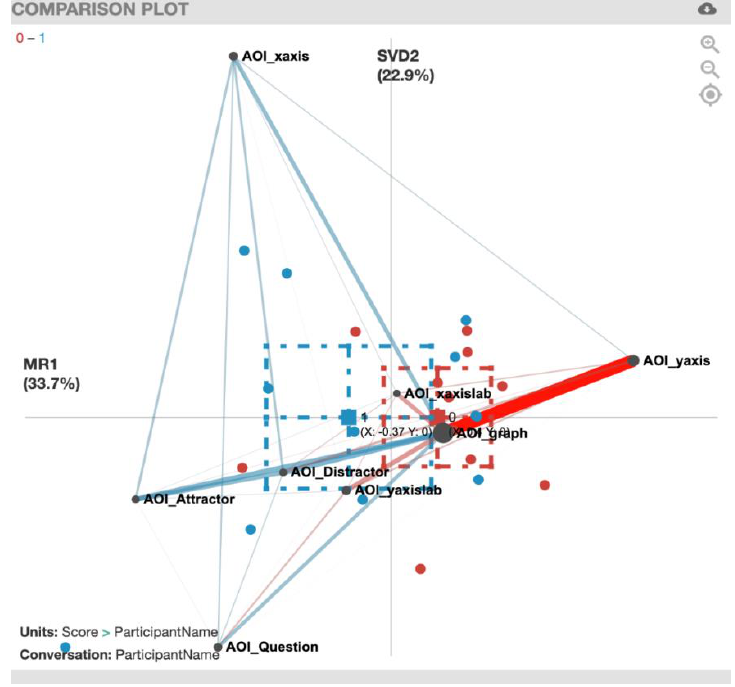
Figure 6. PhyAreaQual transitions with incorrect solvers (red) and correct solvers (blue). For the ENA plot of the EcAreaQuant task (Figure 7), along the x -axis, a two-sample t -test assuming unequal variance (mean = 0.26, SD = 1.10, N = 18) showed statistically significant differences at the alpha level =0.05 (mean = −0.92, SD = 0.81, N = 5; t(8.61) = −2.64, p = 0.03, Cohen’s d = 1.12). The plot shows a strong correlation of gaze transition between the AOI_graph and AOI_yaxislab for the incorrect solvers (red) and a strong gaze transition correlation between AOI_graph and